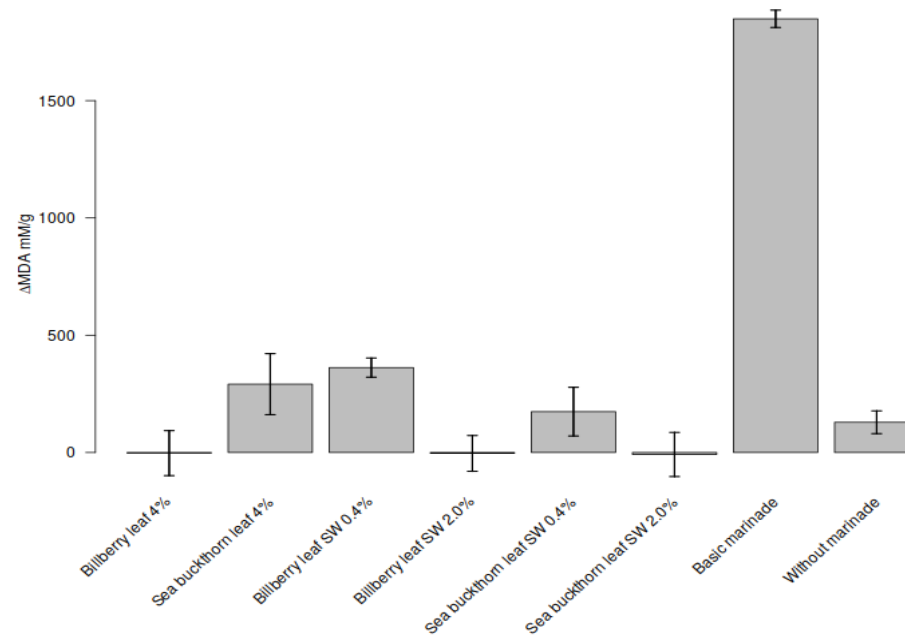
Figure 5. Effects of bilberry and sea buckthorn leaves and their SW extracts on the lipid peroxidation of marinated chicken legs during 8 days of storage.